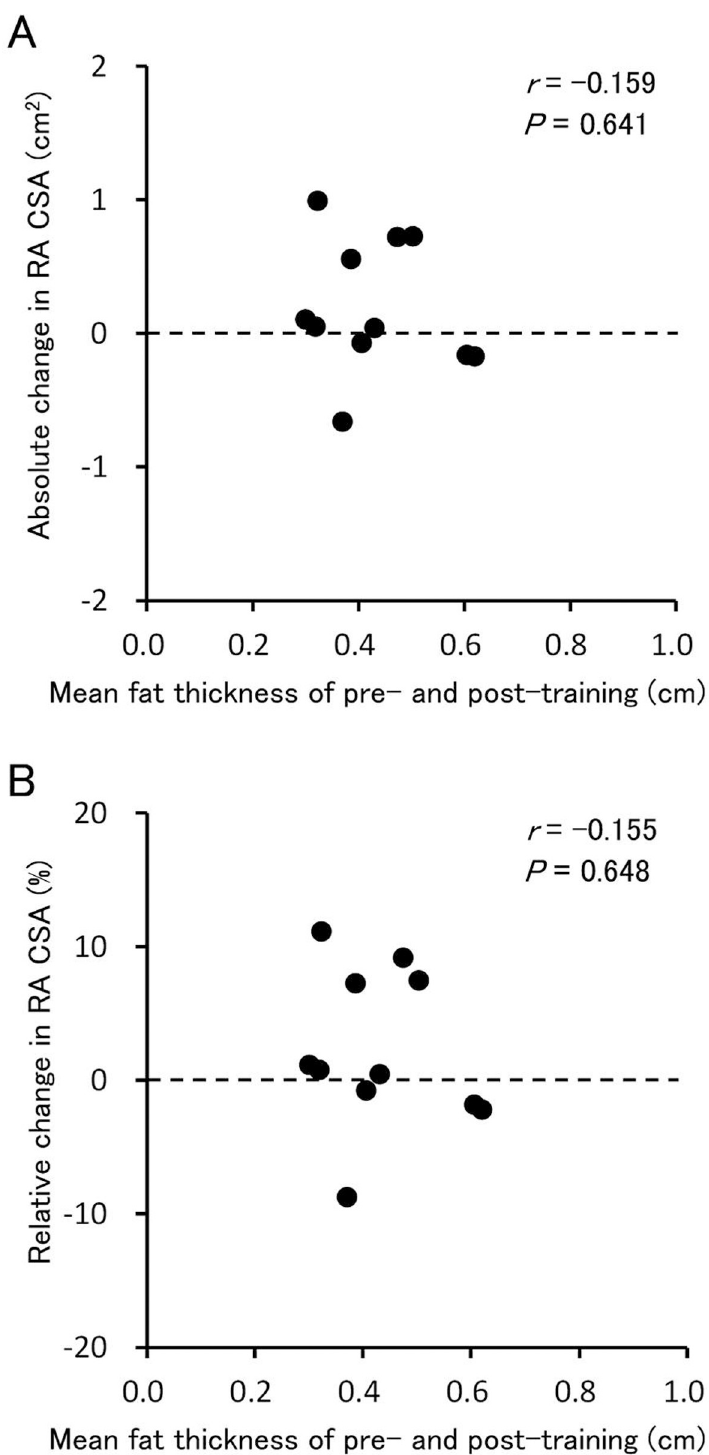
Fig 5. The relationship between mean fat thickness of pre- and post-training and changes in cross-sectional area of the rectus abdominis after training. RA, rectus abdominis; CSA, cross-sectional area. (A) The relationship between mean fat thickness and the absolute change in RA CSA. (B) The relationship between mean fat thickness and the relative change in the CSA.